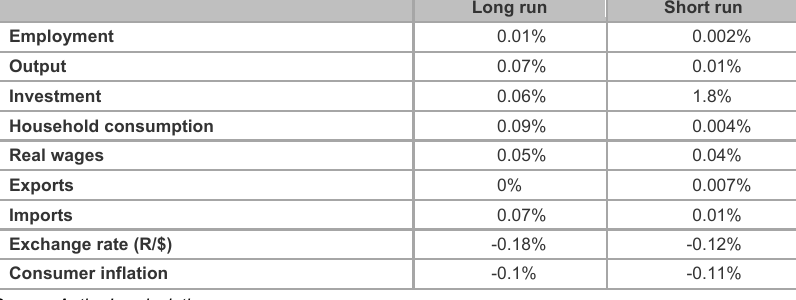
Economy-wide impacts of an increase in Eskom’s capital